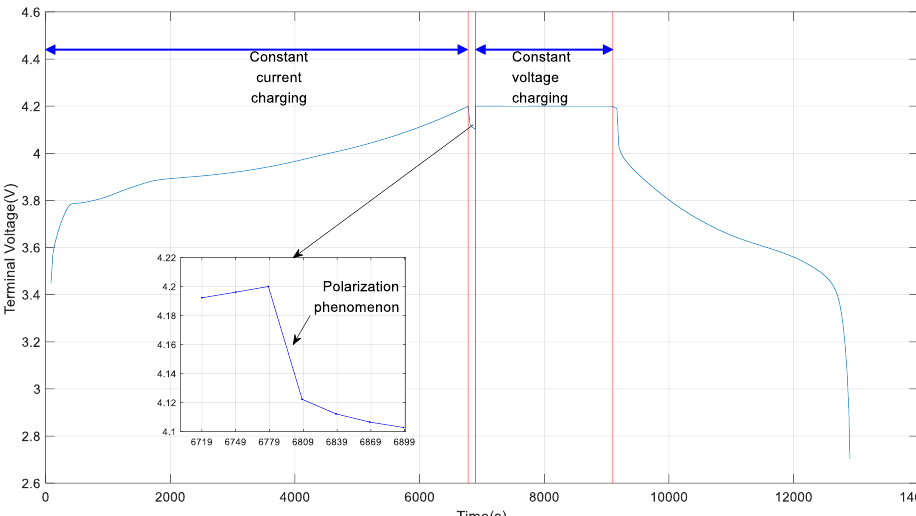
Figure 4. Voltage curve during a single charge-discharge process.